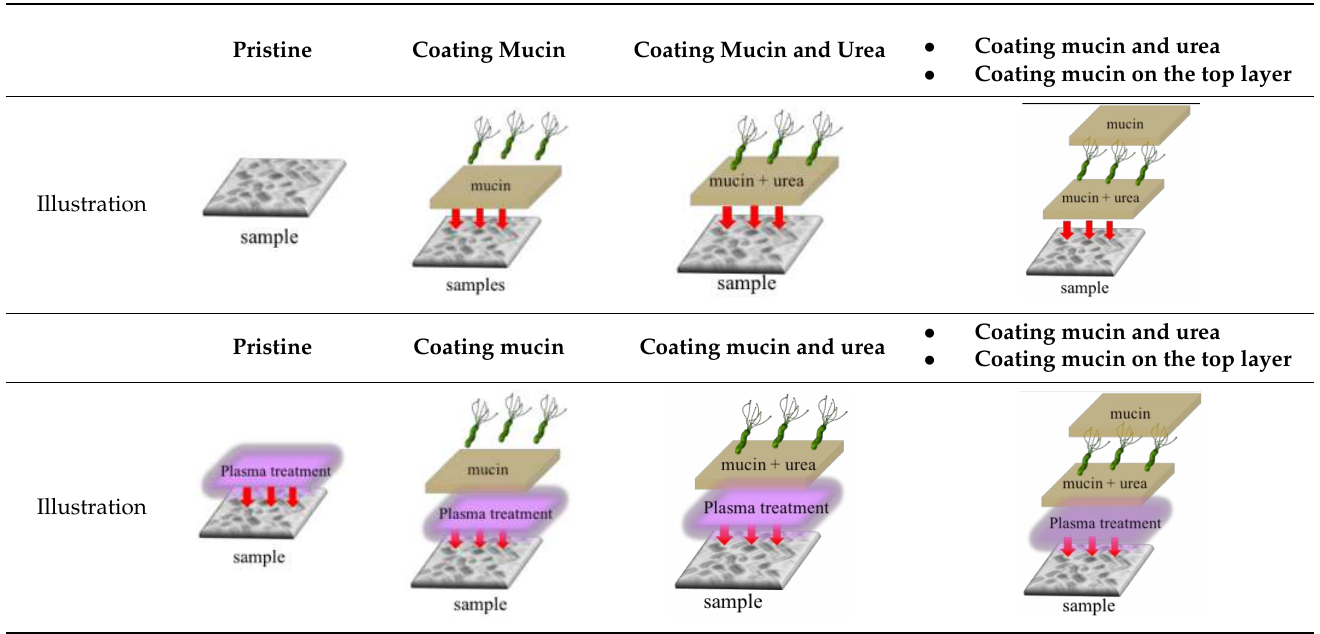
Table 1. Different treatments for culturing H. pylori